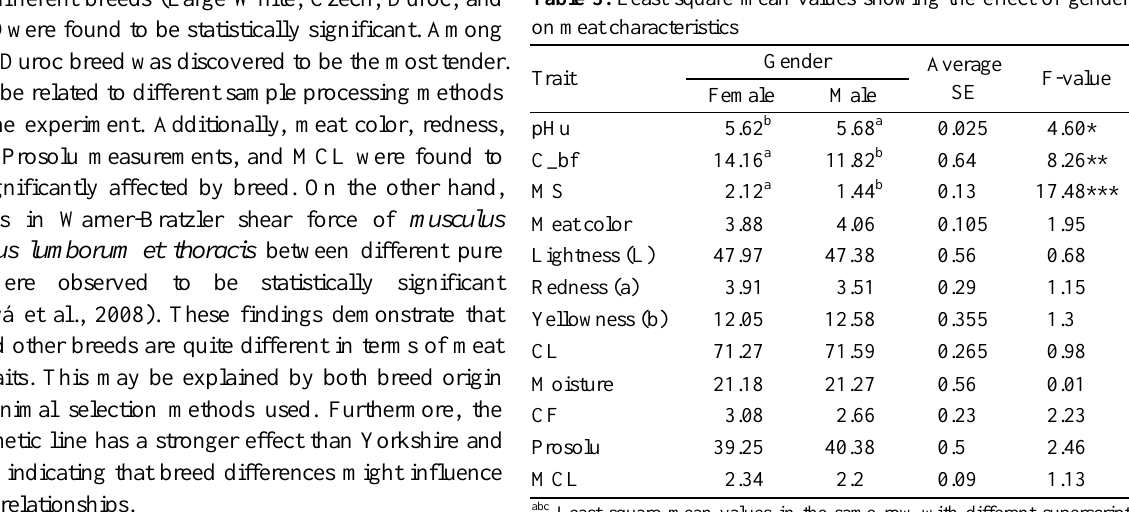
Table 3. Least square mean values showing the effect of gender on meat characteristics Trait